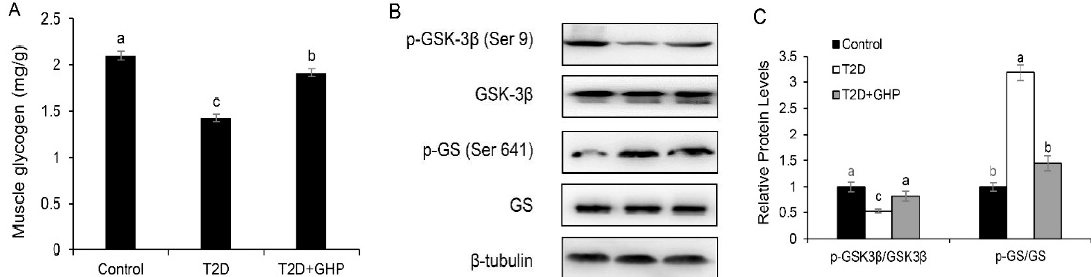
Figure 4. GHP supplementation promotes glycogen synthesis in T2D mice. ( A ) Skeletal muscle glycogen content. ( B ) Protein contents of GSK-3 β , p-GSK-3 β , p-GS and GS in skeletal muscle and ( C ) quantification data. Protein contents were adjusted to β -tubulin as the loading control. Results were expressed as means ± SEM, n = 8. Different letters (a–c) indicate significant difference ( p < 0.05).